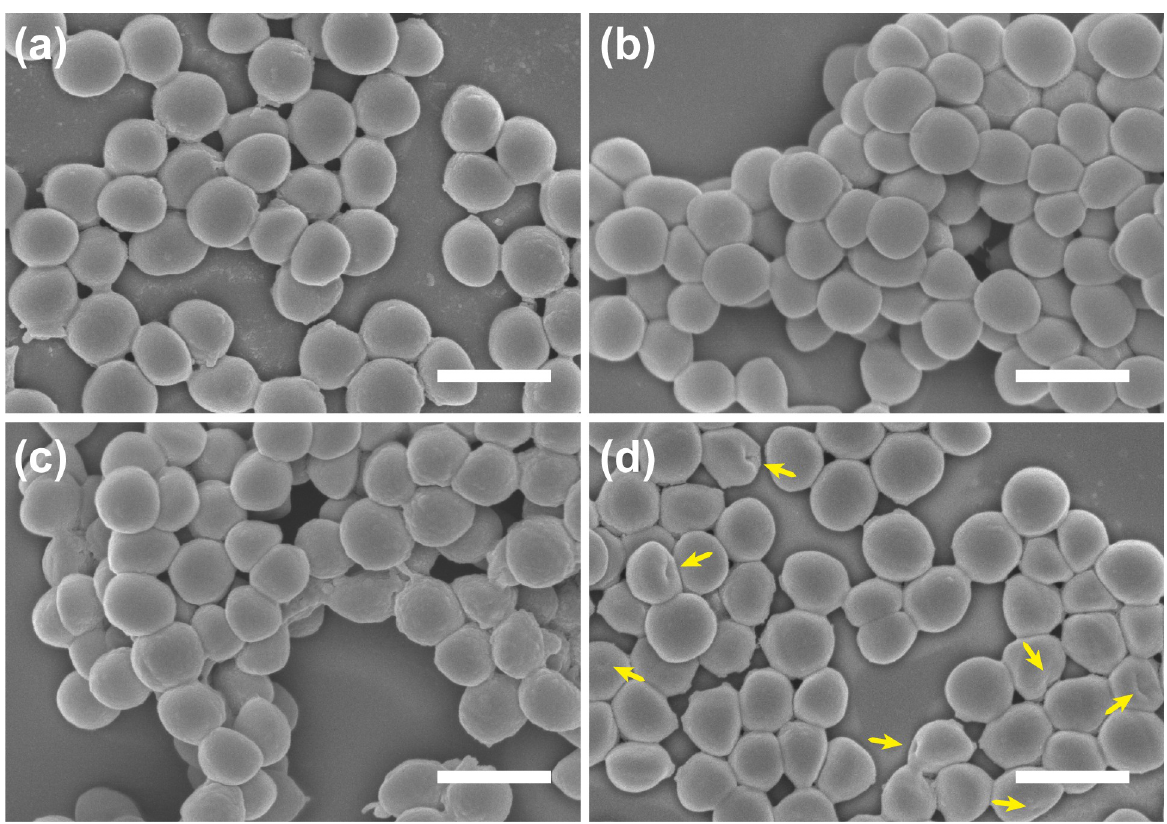
Fig 7. SEM images of MRSA after treatment with (a) no COE, (b) 8 μ M COE-S6 alone, (c) 16 μ M COE-D8 alone, (d) both 16 μ M COE-D8 and 8 μ M COE-S6 , for 4 hours in PBS solution. Scale bars correspond to 1 μ m.